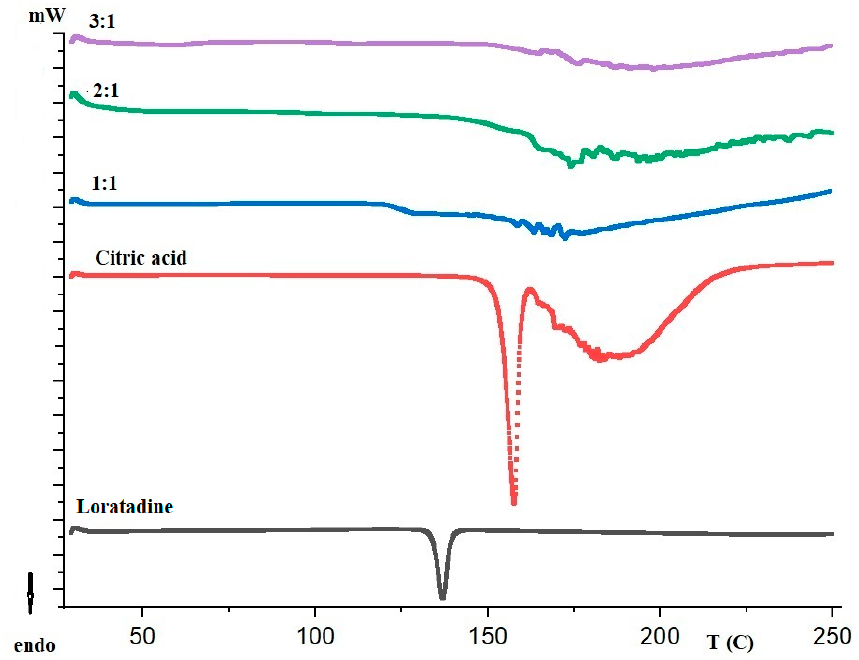
Figure 2. DSC curves of loratadine, citric acid, and binary mixtures 1:1, 2:1, 3:1 of loratadine–citric acid.